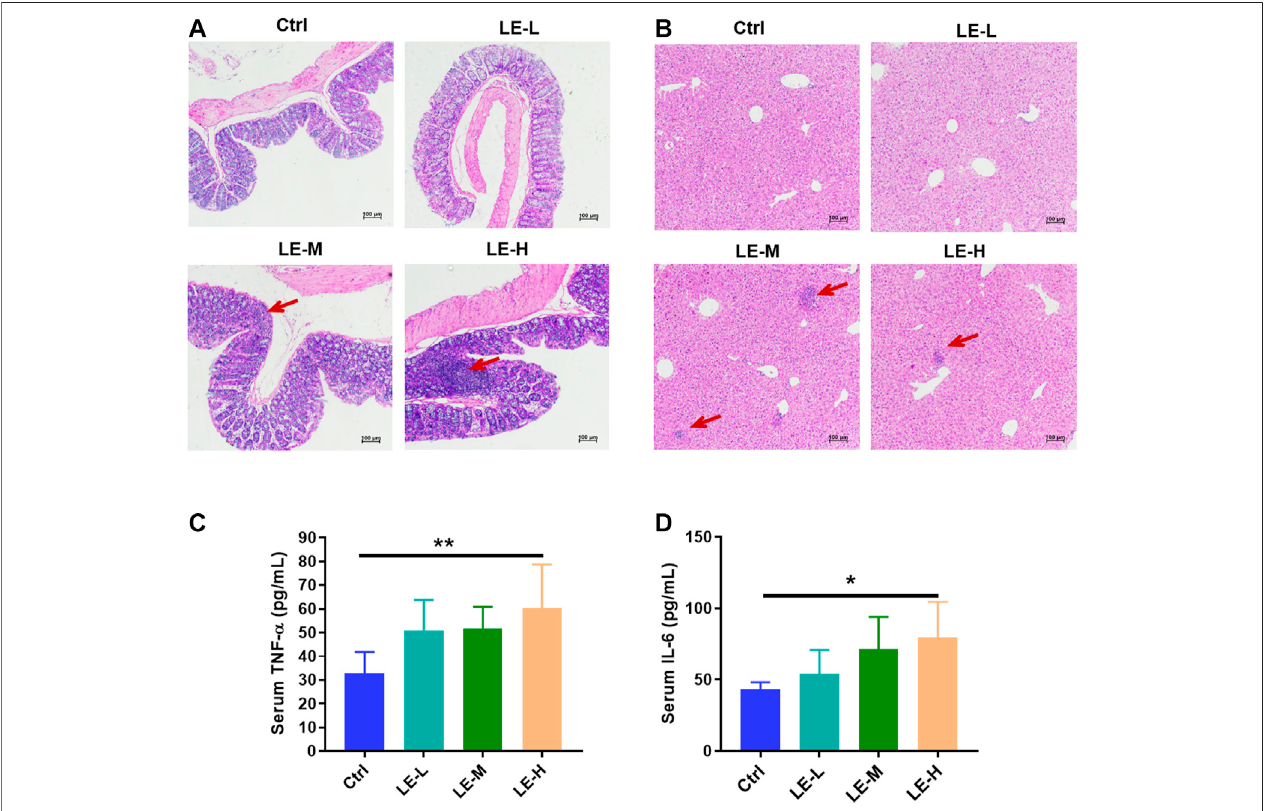
FIGURE1| Excessivelonganintakepromotesin fl ammationinmice.HandEstainingofcolonsections (A) andliversections (B) after2 weeksoflonganextract(LE) treatment.TheoraldosageofLEforCtrl,LE-L,LE-M,andLE-Hgroupare0,4,8and16 g/kg,respectively.Redarrowshowsin fl ammatorycellin fi ltration.Serumlevelsof TNF- α (C) andIL-6 (D) inmiceafter2 weeksofLEintake.Dataarepresentedasmean ± SD( n (cid:1) 7forCtrlgroup; n (cid:1) 5forothergroups).* p < 0.05,** p < 0.01,compared to Ctrl.